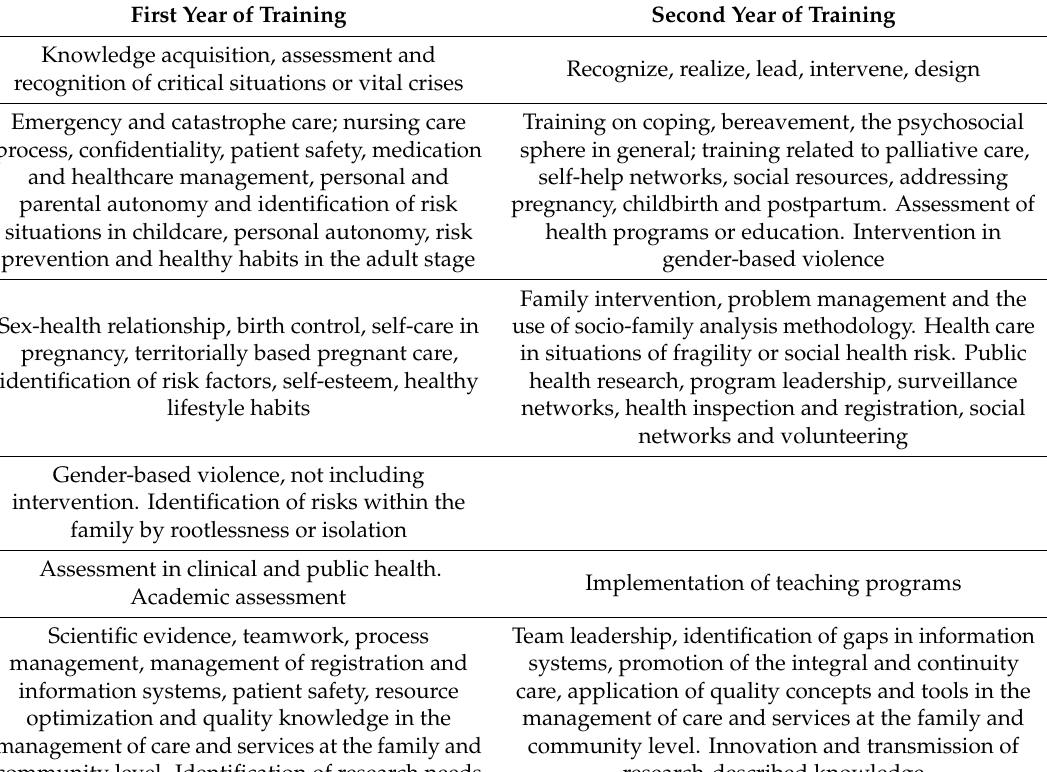
Table 2. Results from the focus group regarding the distribution of primary care nurses’ competencies during the